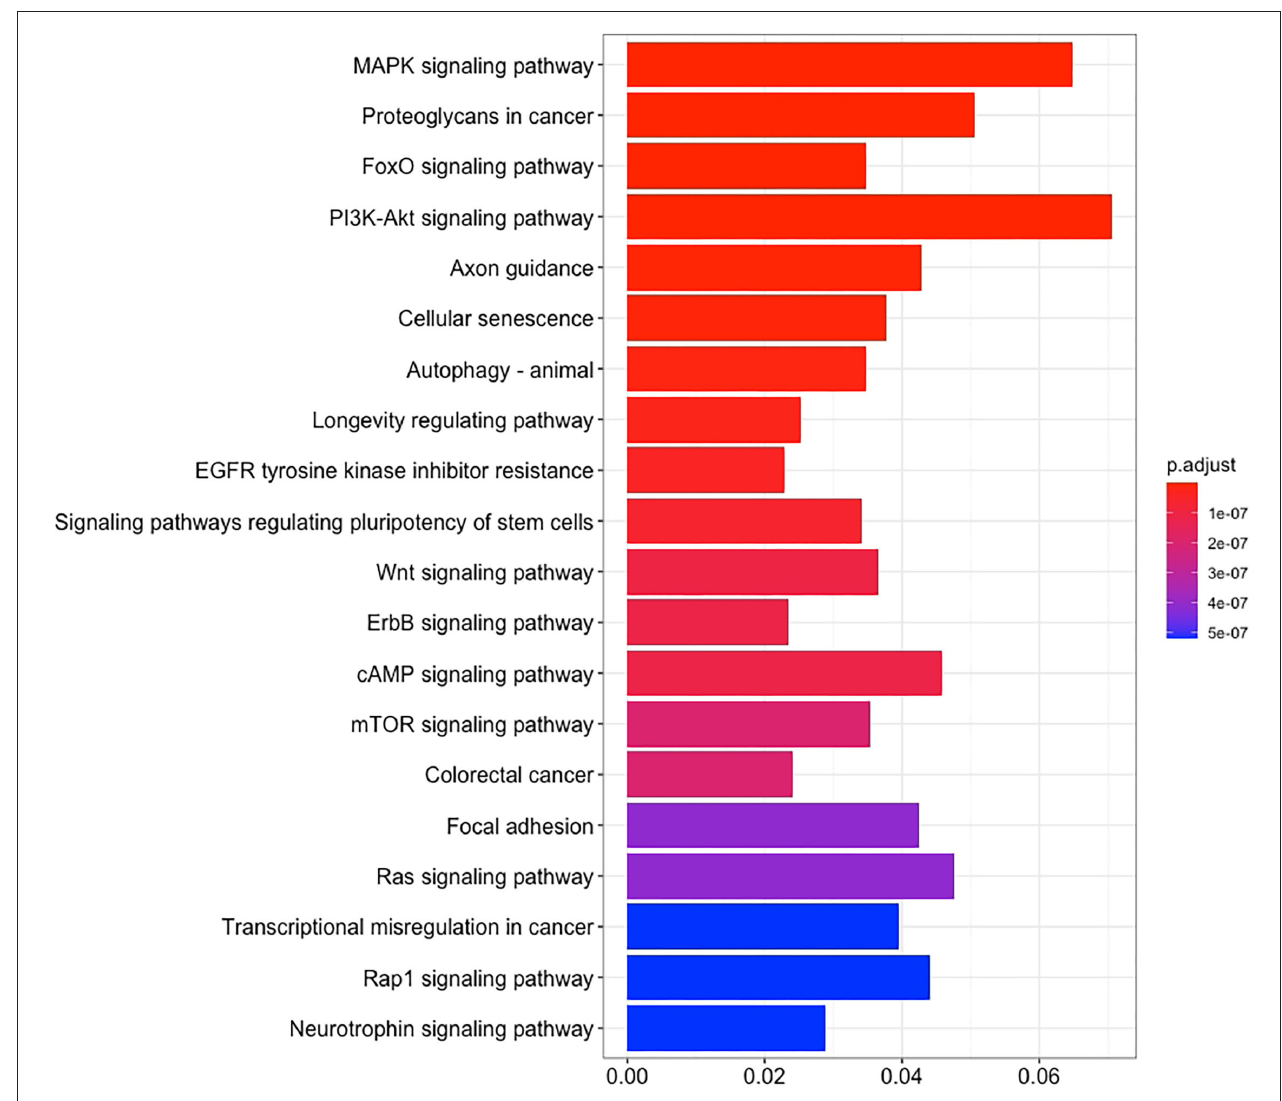
FIGURE 4 | The enrichment maps of GO were analyzed from 14